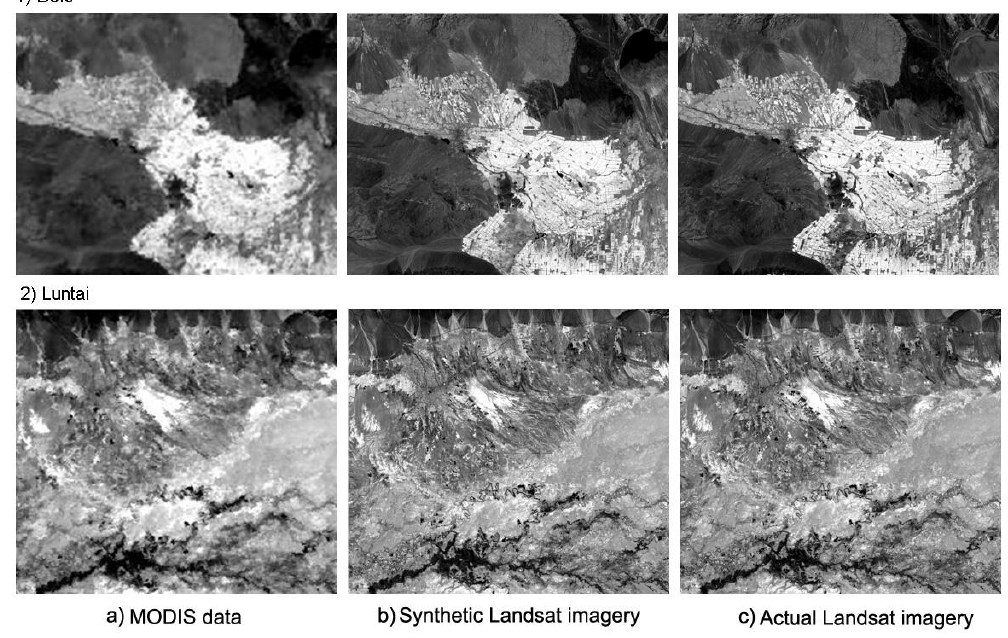
Figure 3. Comparison of Near-infrared (NIR) band surface reflectance data of the Moderate Resolution Imaging Spectroradiometer (MODIS; left ), synthetic Landsat image ( middle ); and actual Landsat image ( right ) acquired on 11 July 2011 in Bole (upper panels) and 6 October 2013 in Luntai (lower panels),